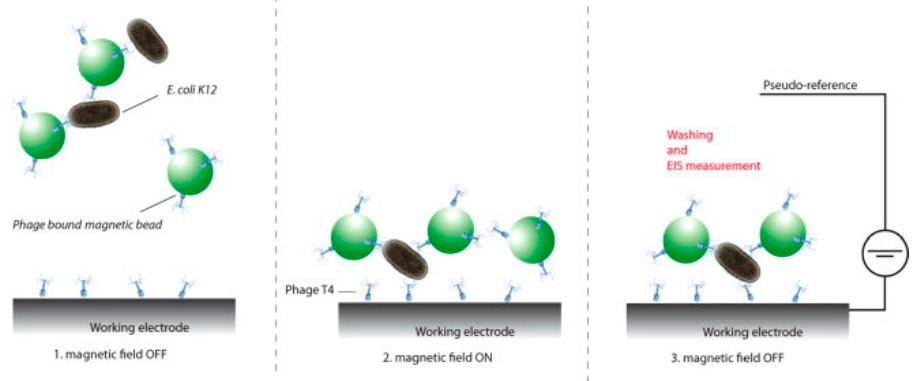
Figure 12. Illustration of the screen-printed carbon electrode and its use for the EIS detection of magnetically separated E. coli K12 using immobilized bacteriophages (adapted with permission from [32]).